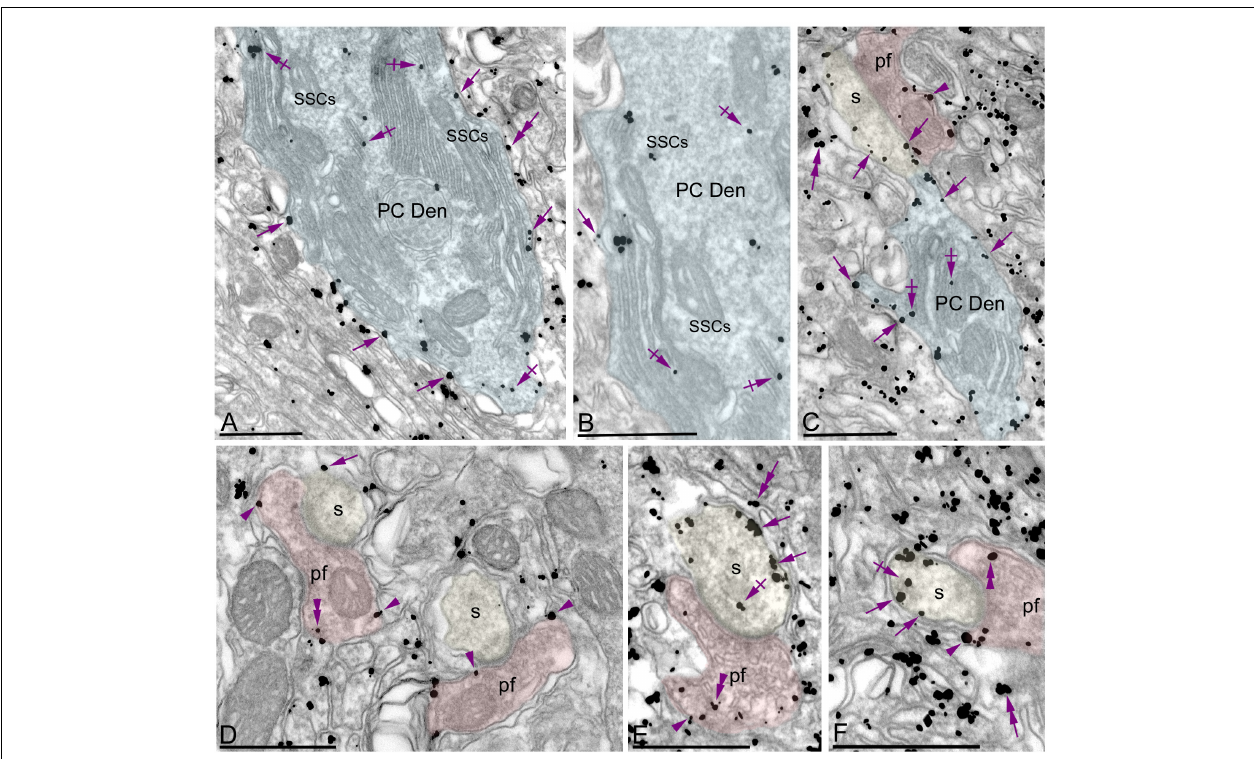
FIGURE 3 | Subcellular localization of G α o in PCs. Electron micrographs showing immunoparticles for G α o in the molecular layer of the cerebellum, as detected using a pre-embedding immunogold technique. (A–F) Most immunoparticles for G α o were distributed along the extrasynaptic plasma membrane (arrows) of dendritic shafts (Den, blue transparent overlay) and spines (s, yellow transparent overlay) of PCs contacted by parallel fiber terminals (pf, red transparent overlay). To a lesser extent, immunoparticles for G α o were detected at intracellular sites (crossed arrows) associated with intracellular membranes and more frequently with subsurface cisterns (SSCs) belonging to the endoplasmic reticulum. Presynaptically, G α o immunoparticles were also distributed along the plasma membrane and at intracellular sites (arrowheads) in axon terminals of parallel fibers (pf). In addition to PCs, immunoparticles for G α o were detected in Bergmann glia cells (double arrows). Scale bars: (A–F) 500